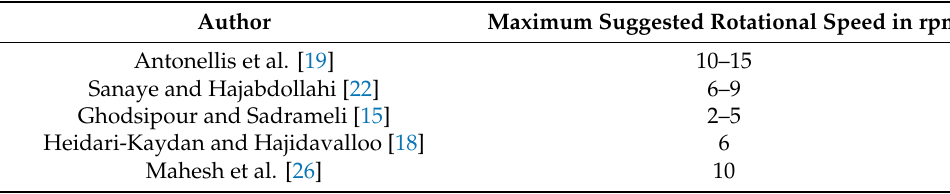
Table 8. Maximum suggested rotational speed according to di ff erent